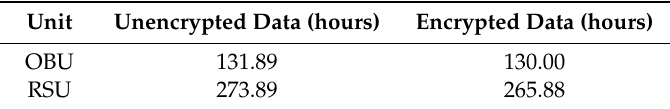
Table 8. Running time of OBU and RSU with 3.7 V, 1000 mAh battery.